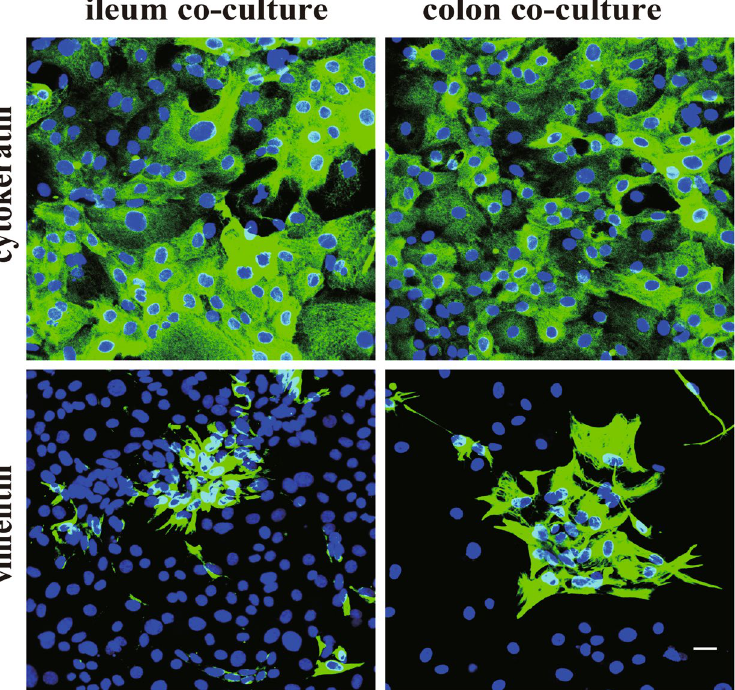
Figure 4. Characterization of the primary porcine ileum and colon epithelial cells co-cultured with ileum myofibroblasts. Immunofluorescence staining against cytokeratin and vimentin for ileum and colon epithelial cells co-cultured with myofibroblasts 3 days post seeding. Scale bar: 25 µ